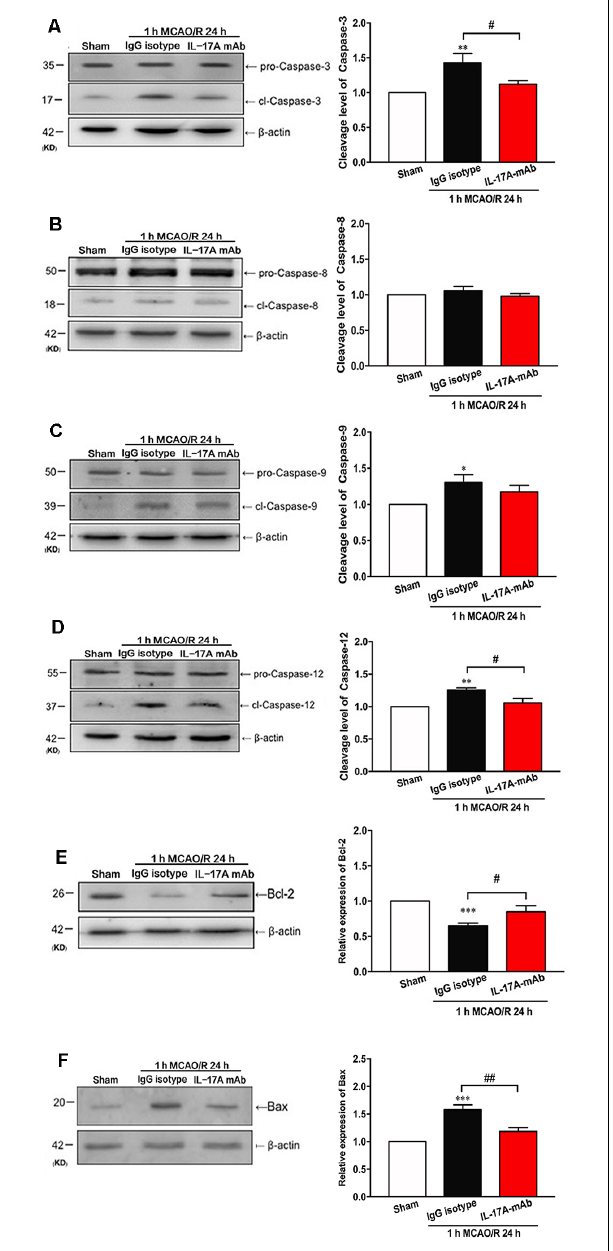
FIGURE 3 | IL-17A-neutralizing mAb alleviated the neural cell apoptosis in the peri-infarct region of mice with ischemic stroke through caspase-12-dependent pathway. The representative and quantitative analysis results of Western blot showed that the i.c.v. injection of IL-17A-neutralizing mAb (2.0 µ g) could significantly inhibit the cleavage levels of caspase-3 (A) and caspase-12 (D) in the peri-infarct region of mice following 1-h MCAO/R 24 h. In addition, the injection of IL-17A-neutralizing mAb could significantly increase Bcl-2 expression levels (E) , but decrease the expression levels of Bax (F) in the peri-infarct region of mice with ischemic stroke. However, the injection of IL-17A-neutralizing mAb did not affect the cleavage levels of caspase-8 (B) and caspase-9 (C) in the peri-infarct region of mice after 1-h MCAO/R 24-h treatment. Data are presented as mean ± SEM; ∗ p < 0.05, ∗∗ p < 0.01, ∗∗∗ p < 0.001 vs. sham group; # p < 0.05, ## p < 0.01 vs. 1-h MCAO/R 24 h + IgG isotype group ( n = 6 per